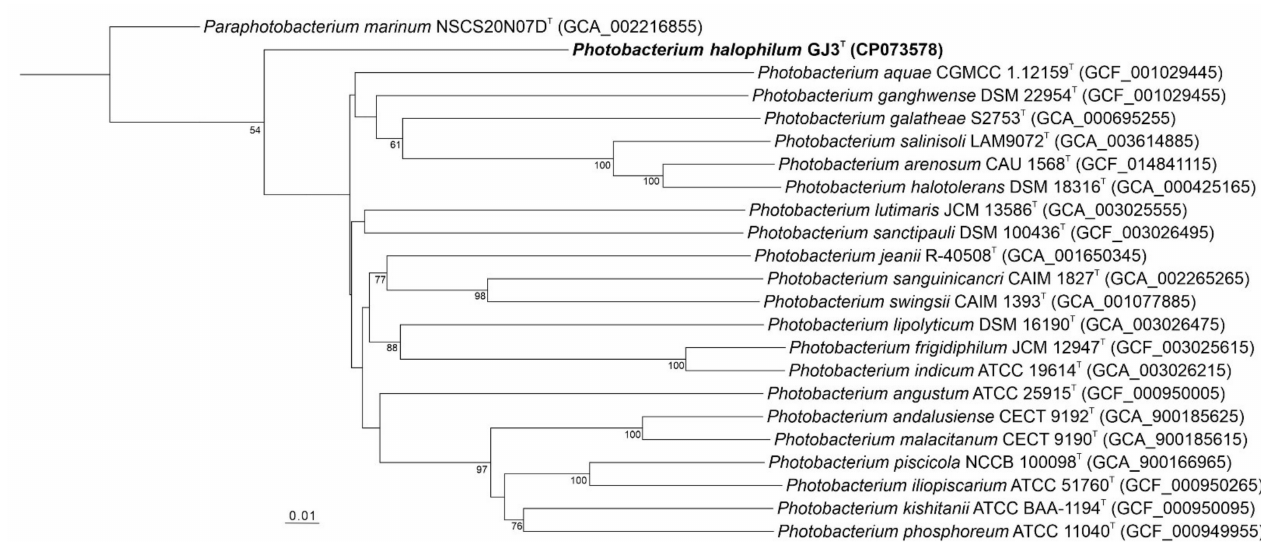
Figure 1. Neighbor-joining tree based on 16S rRNA gene sequences showing the phylogenetic rela- tionship of strain GJ3 T and related strains, including validated members of the genus Photobacterium . The sequence of Marinobacter hydrocarbonoclasticus ATCC 49840 T (X67022) was used as an outgroup in this study. GenBank accession numbers are given in parentheses. Bootstrap values (>50%) based on 1000 replications are shown at nodes based on neighbor-joining, maximum likelihood, and maximum parsimony methods. Filled circles indicated that the corresponding nodes were also obtained in the trees generated with the neighbor-joining, maximum likelihood, and maximum parsimony methods. Bars, 0.02 substitutions per nucleotide position.